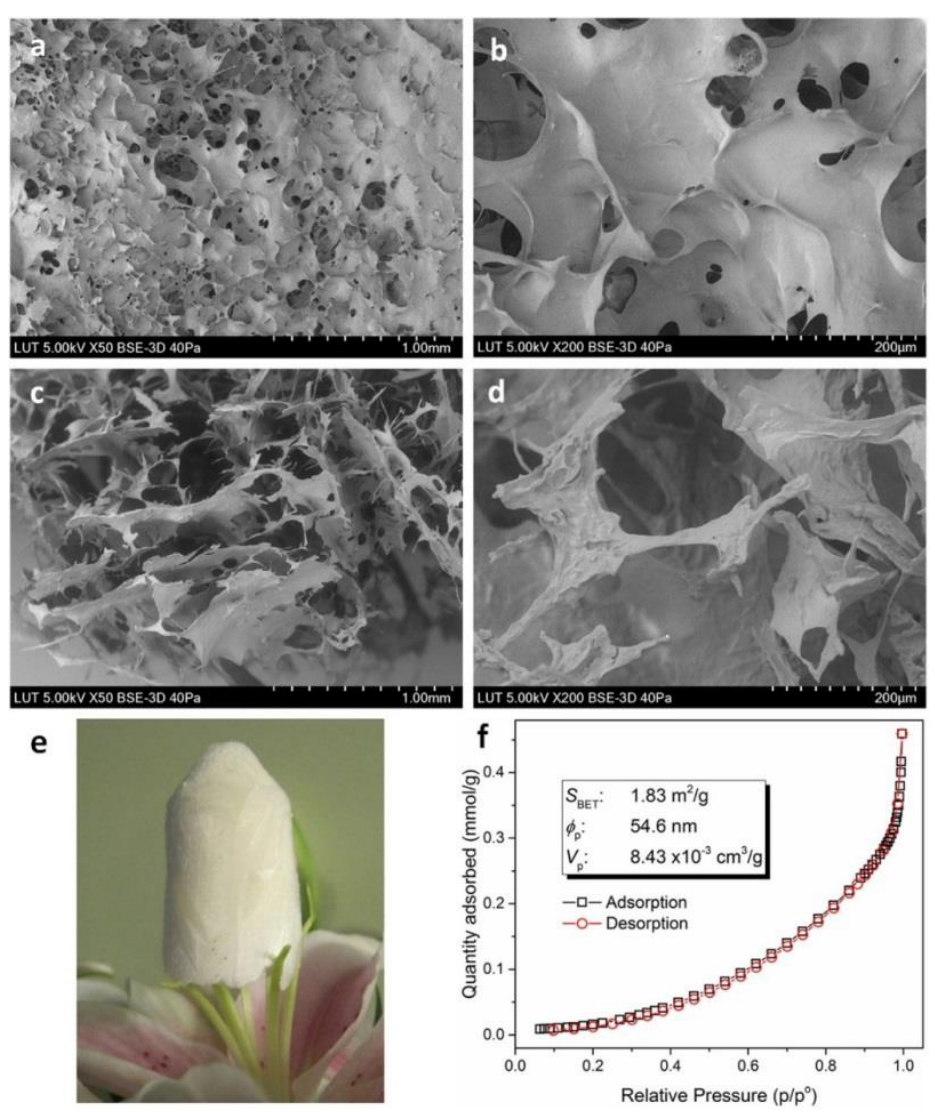
Figure 6. SEM images of freeze-dried CS-ED-CS polymer. Surface morphologies ( a , b ) and cross-sectional morphologies ( c , d ) of CS-ED-CD hydrogel with varying magnifications; a block of freeze- dried CS-ED-CD hydrogel standing on the stamens of a lilium flower ( e ); and BET isotherm linear plot and BET surface area ( f ), average pore diameter and cumulative pore volume data for CS-ED-CD [26]. Lessa et al., in order to adsorb from wastewaters metamizol (MET), acetylsalicylic acid (ASA), and acetaminophen (ACE) used a waste coffee grounds (WCG)-chitosan-poly (vinyl alcohol) (WCG-CA-PVA) composite. The concentration of 10% WCG in the system seems to be effective for the formulation, adding enough adsorption sites. SEM images indicate that increase in the WCG percentage provoke rougher surfaces and some aggregates, perhaps because there is a destruction of the compatibility of the polymer matrix and the filler. The main advantage of this research is the cost-beneficial process using the aforementioned waste and also the reusability in at least five cycles